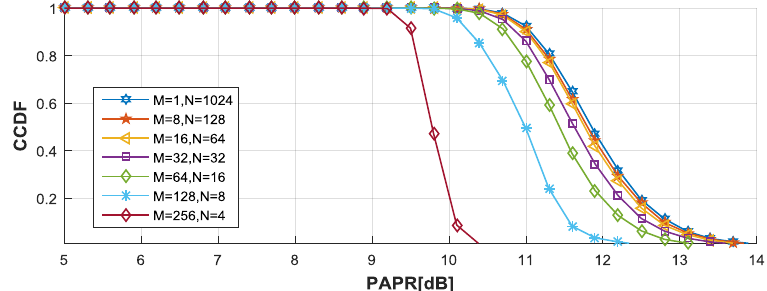
Figure 8. Complementary cumulative distribution function ( CCDF) curve of peak-to-average power ratio (PAPR) of the UWAOSDM/PN system.